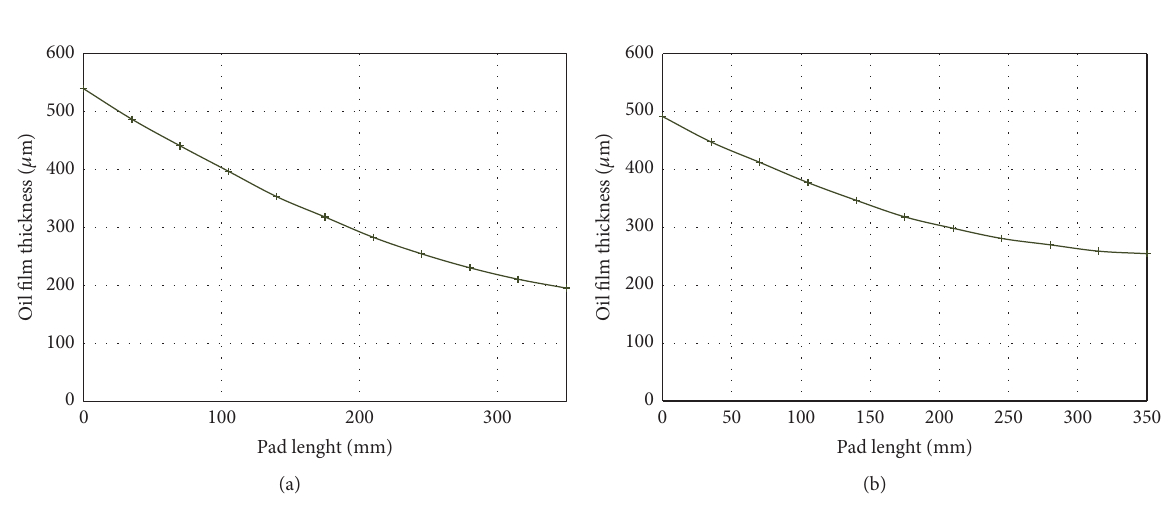
Figure 14: Measured distributions of the oil film thickness on pad number 4 of the UJB of a LHG: (a) at speed-no-load condition; (b) at nominal load condition (700